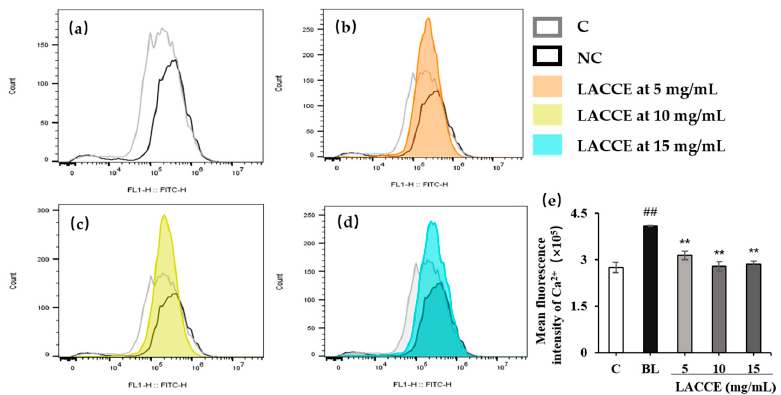
Figure 9. Effects of the LACCE on Ca 2+ . ( a ) Comparison of the Ca 2+ inflow between the blank control group (C) and blue light model group (BL). ( b ) Influence of 5 mg/mL LACCE on Ca 2+ inflow. ( c ) Influence of 10 mg/mL LACCE on Ca 2+ inflow. ( d ) Influence of 15 mg/mL LACCE on Ca 2+ inflow. ( e ) Quantitative analysis of the fluorescence intensity of Ca 2+ ( n = 3). The data are expressed as mean ± standard deviation (SD) of three independent experiments. The data were analyzed using one-way analysis of variance (ANOVA) followed by Tukey’s test. ## p < 0.01 vs. C. ** p < 0.01 vs.